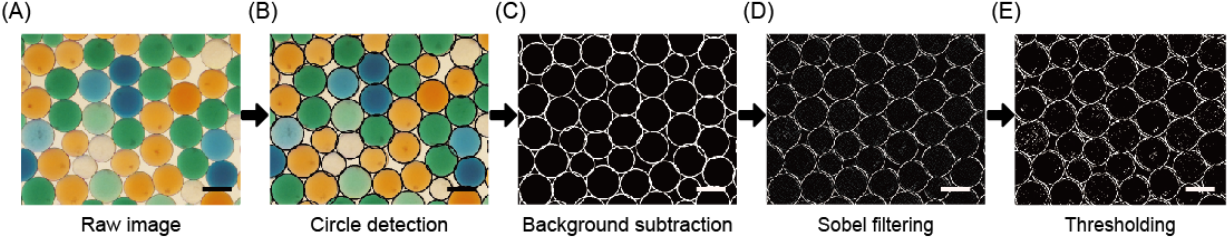
Figure 1. Image analysis processes of color-coded droplets. ( A ) Raw image, ( B ) circle detection, ( C ) background subtraction, ( D ) Sobel filtering, and ( E ) thresholding. Scale bars represent 100 µm.